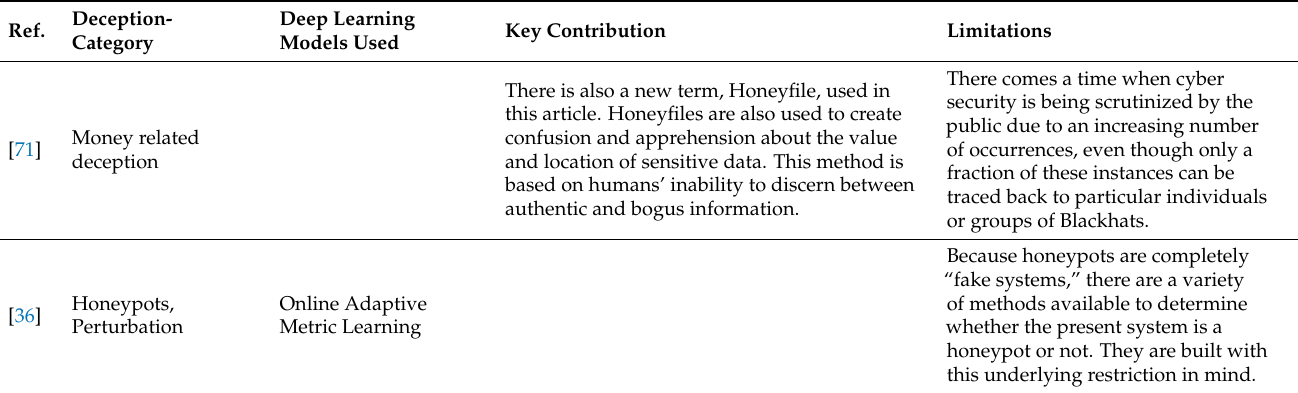
Table 3. A summary of works on Deep Learning Models in Defensive